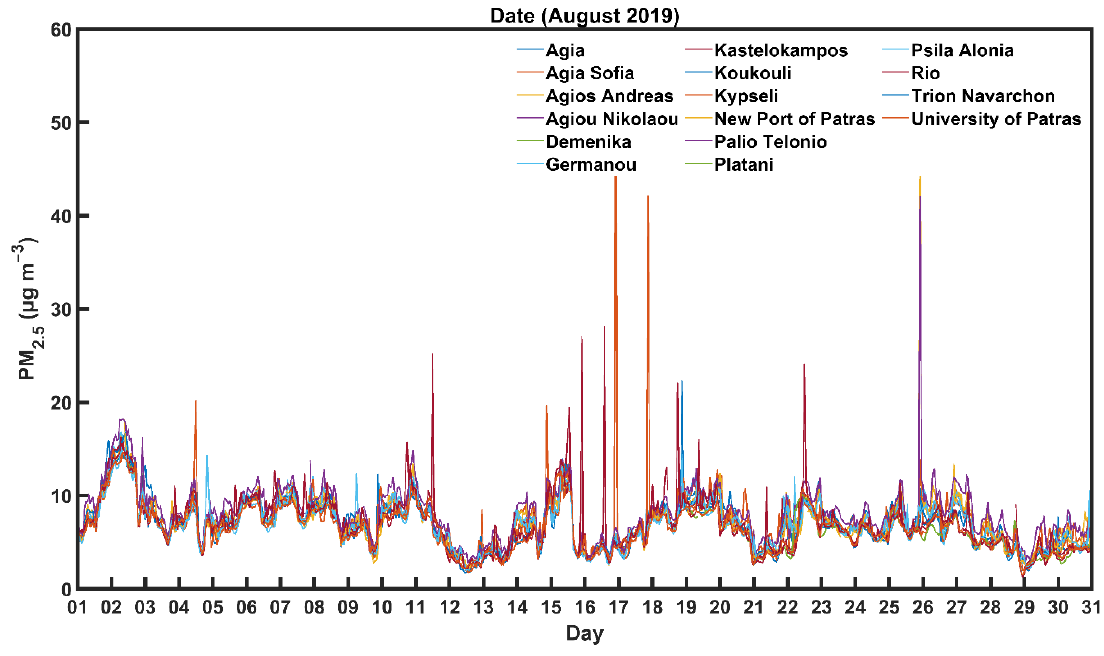
Figure 2. PM 2.5 hourly measurements of 16 low-cost sensors installed in different areas of Patras during August 2019.